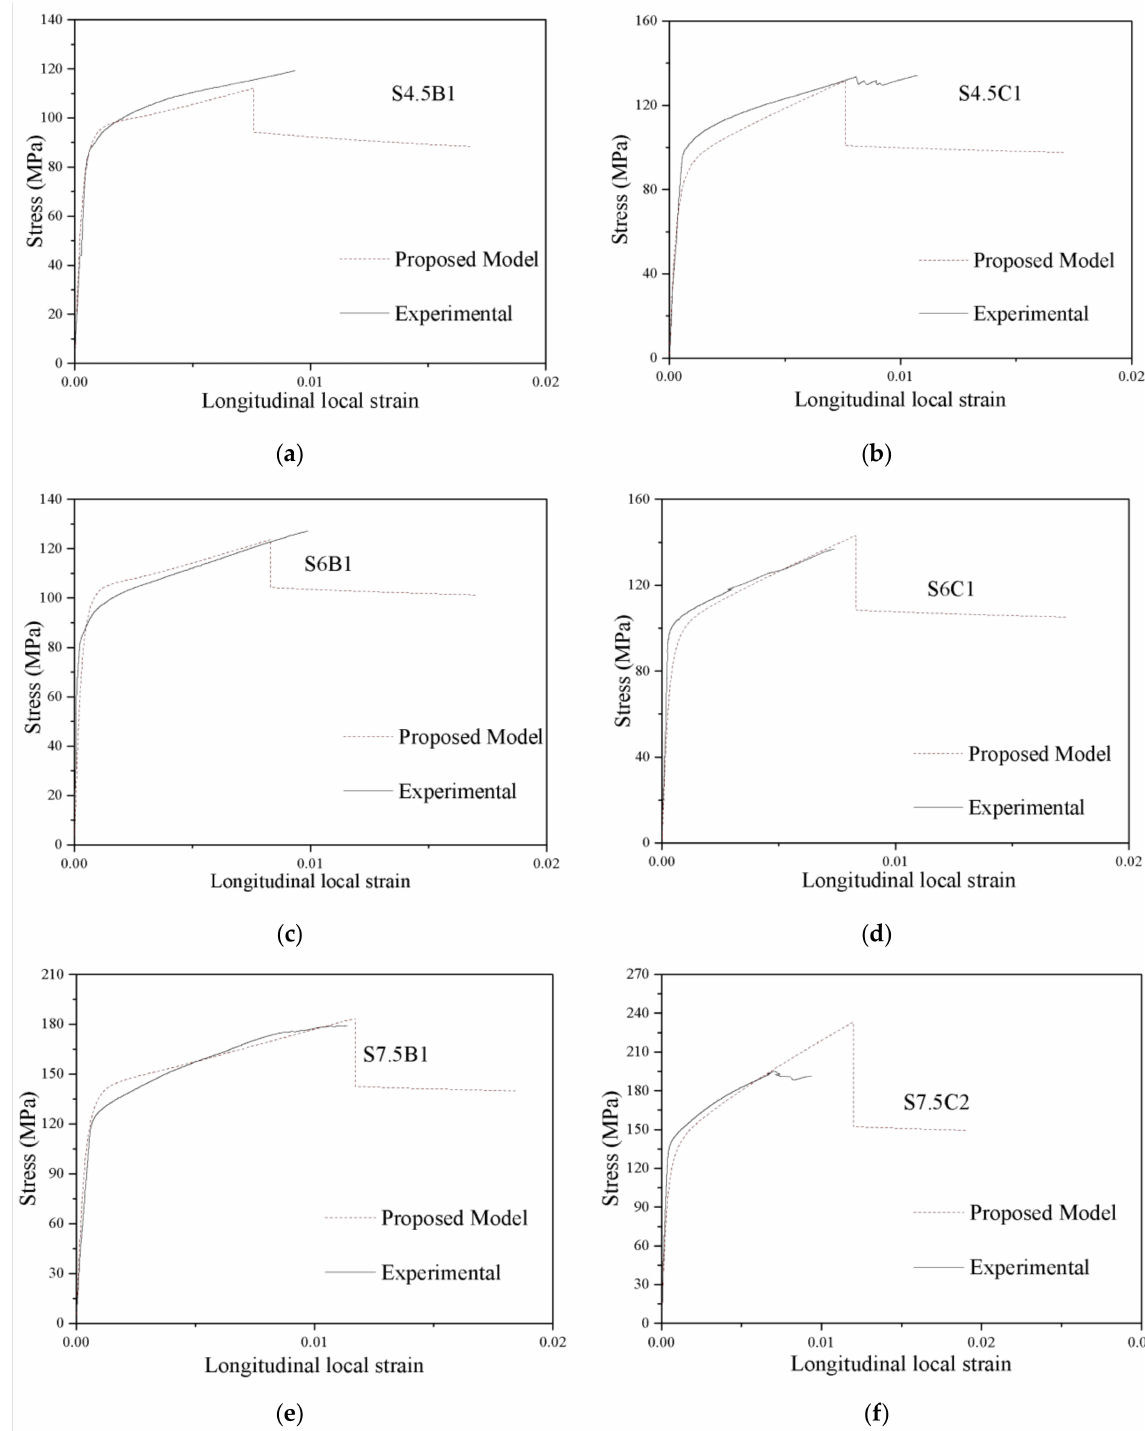
Figure 15. Evaluation of stress-local strain curves of CFGCT columns. ( a ) S4.5B1. ( b ) S4.5C1. ( c ) S6B1. ( d ) S6C1. ( e ) S7.5B1. ( f )